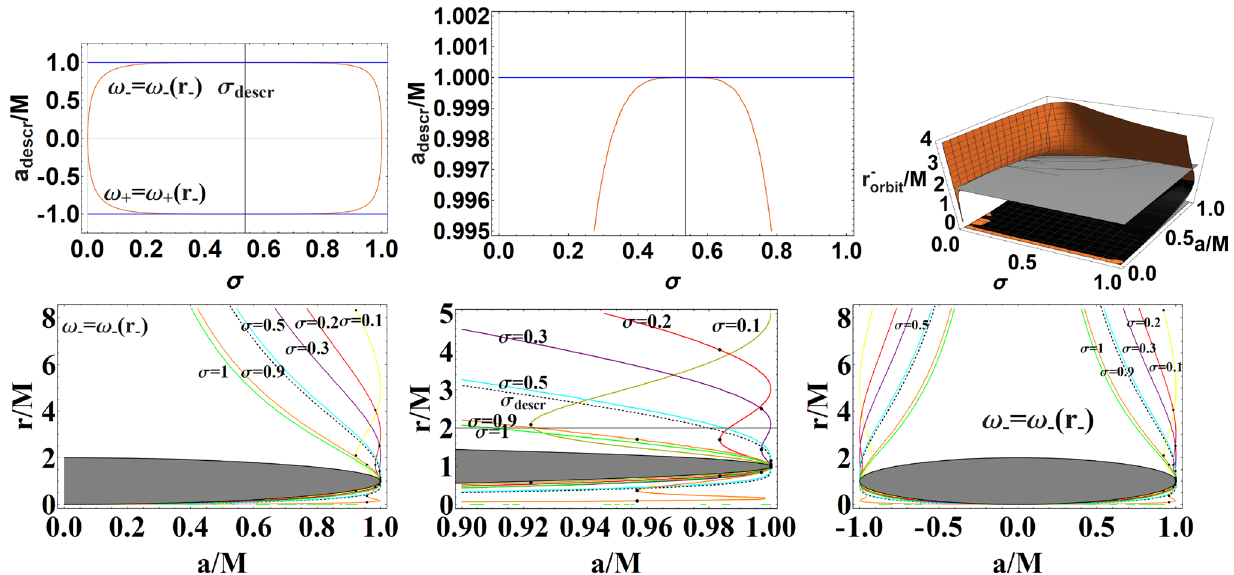
in the right panel. The black region is a BH on the extended plane ( r ∈ [ r − , r + ] ). Below panel: solutions ω − = ω − ( r − ) as functions of r / M for σ ∈ [ 0 , 1 ] and a ∈ [ 0 , M ] . The gray region represents the ergosphere on the extended